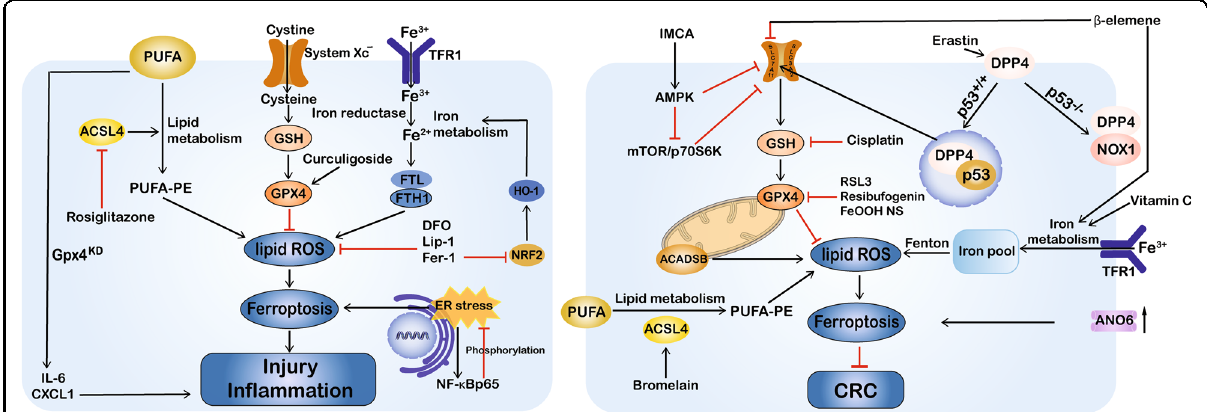
Fig. 2 Dual regulatory roles for ferroptosis in intestinal diseases. Ferroptosis can be a positive and negative regulator of intestinal diseases according to cell type and disease context. The induction of ferroptosis by multiple compounds can inhibit cancer growth; however, inhibiting ferroptosis has an anti-in fl ammatory effect and can attenuate intestinal injury in IBD and I/R injury. This schematic diagram shows ferroptosis regulators and pathways. ACADSB acyl-Coenzyme A dehydrogenase short/branched chain, ACSL4 acyl-CoA synthetase long-chain family member 4, ANO6 anoctamin 6, CRC colorectal cancer, CXCL1 chemokine (C-X-C motif) ligand 1, DFO deferoxamine, DPP4 dipeptidyl-peptidase-4, ER endoplasmic reticulum, Fer-1 ferrostatin-1, FTL ferritin light chain, FTH1 ferritin heavy chain 1, FeOOH NS iron oxide-hydroxide nanospindle, GPX4 glutathione peroxidase 4, GSH glutathione, HO-1 haem oxygenase 1, IMCA 2-Imino-6-methoxy-2H-chromene-3-carbothioamide, I/R ischaemia/ reperfusion, IBD in fl ammatory bowel disease, IL-6 interleukin 6, KD knockdown, Lip-1 liproxstatin-1, NOX1 NADPH oxidase 1, NRF2 nuclear factor E2-related factor 2, PUFA polyunsaturated fatty acid, PE phosphatidylethanolamine, ROS reactive oxygen species, RSL3 Ras-selective lethal small molecule 3, SLC7A11 solute carrier family 7 member 11, TFR1 transferrin receptor